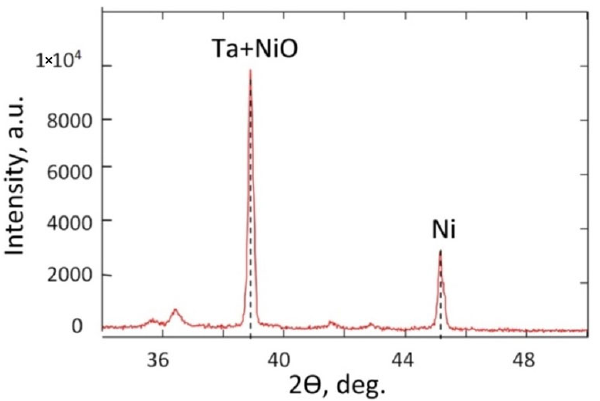
Figure 7. XRD spectrum of the experimental sample of the Ta/Ta 2 O 5 pillars with Ni tips. Table 3. Results of the X ‐ ray structural analysis of the Ta/Ta 2 O 5 /Ni experimental samples. The values in parentheses in the 2 θ column are the corresponding angles from the JCPDS database.